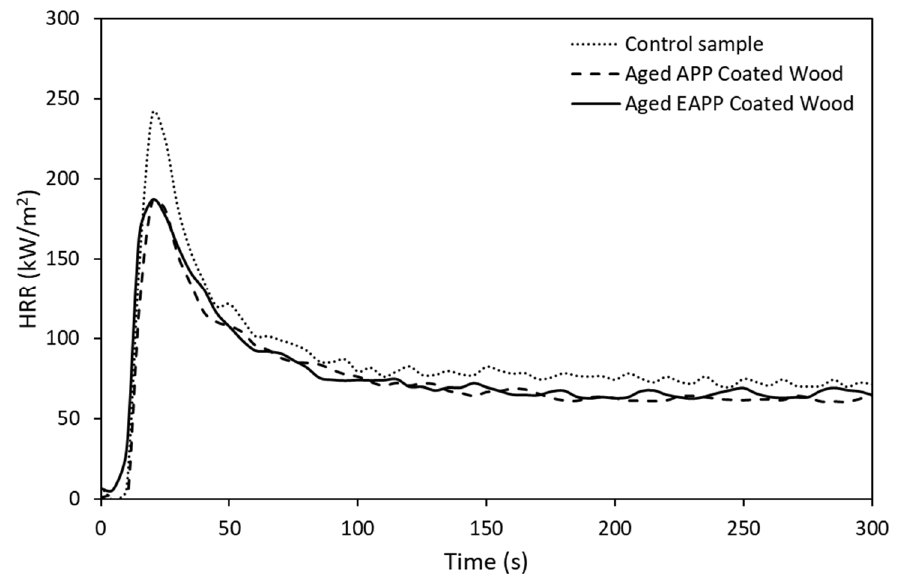
Figure 7. HRR curves of aged intumescent coated wood samples and control wood sample.